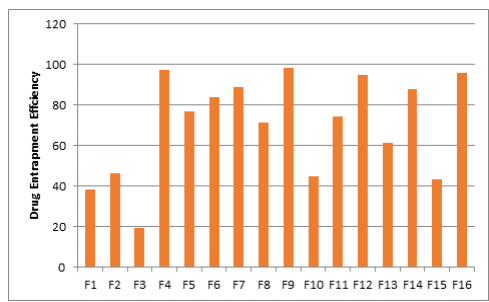
Figure 5. Entrapment efficiency of ITZ floating microparticles.